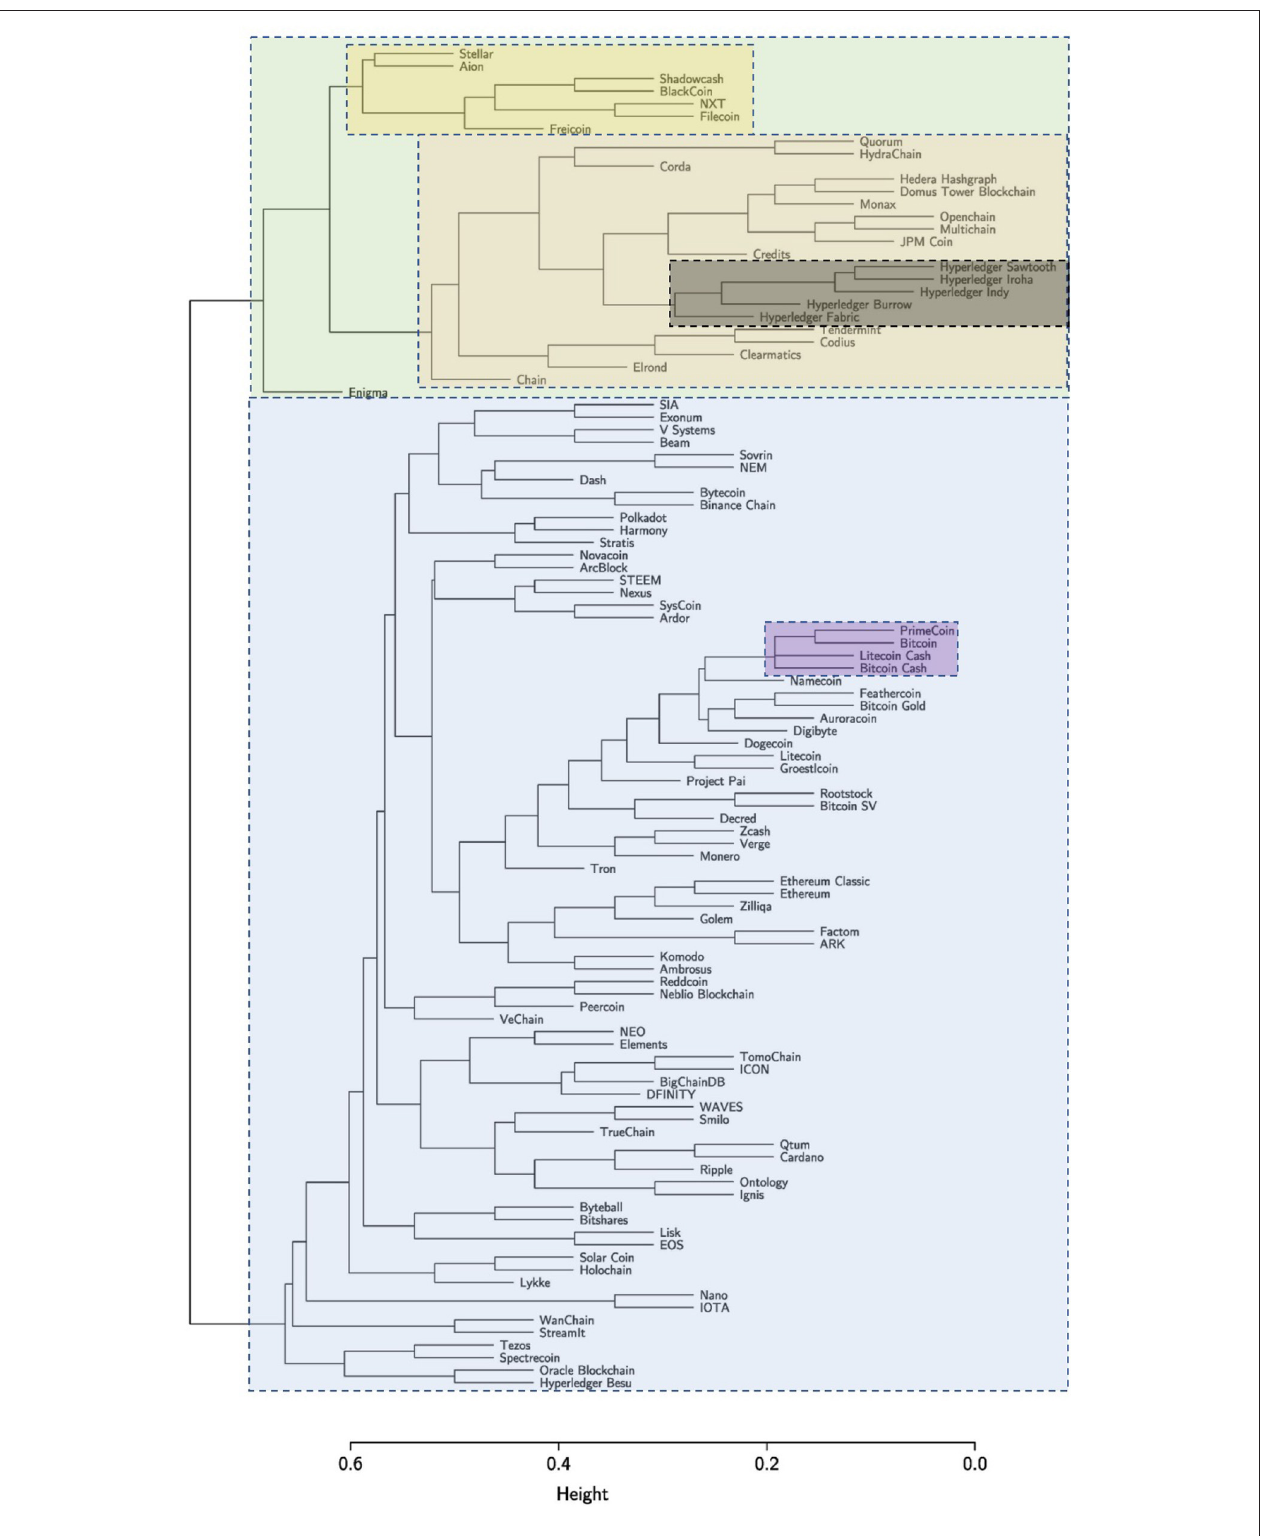
FIGURE 8 | The dendograms shows several subclusters of blockchain technologies.